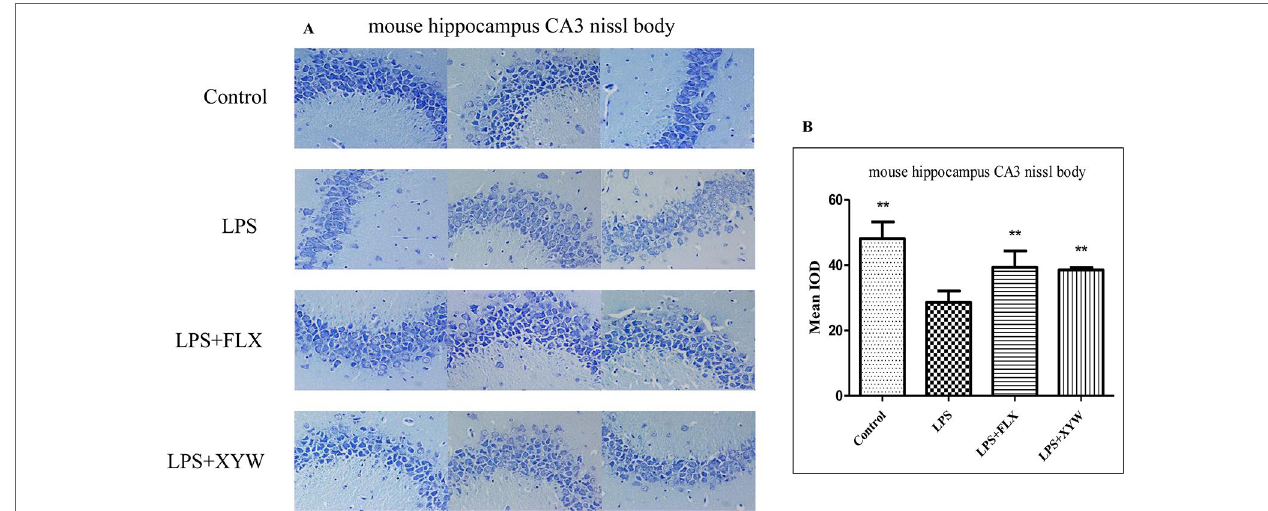
FIgURe 7 | LPS administration caused hippocampal neuronal damage. (a, B) Mice, LPS-treated reduced Nissl bodies, and a significant decrease in the average optical density [28.69 ± 3.40 vs 48.14 ± 5.03 (control), N = 4] (P 0.05 or P 0.01), with 2 weeks of prior XYW administration (LPS + XYW), exhibited a significant improvement of the average optical density value in Nissl bodies than the control rats (28.69 ± 3.40 vs 38.54 ± 0.78, N = 4) (P 0.01) (B: